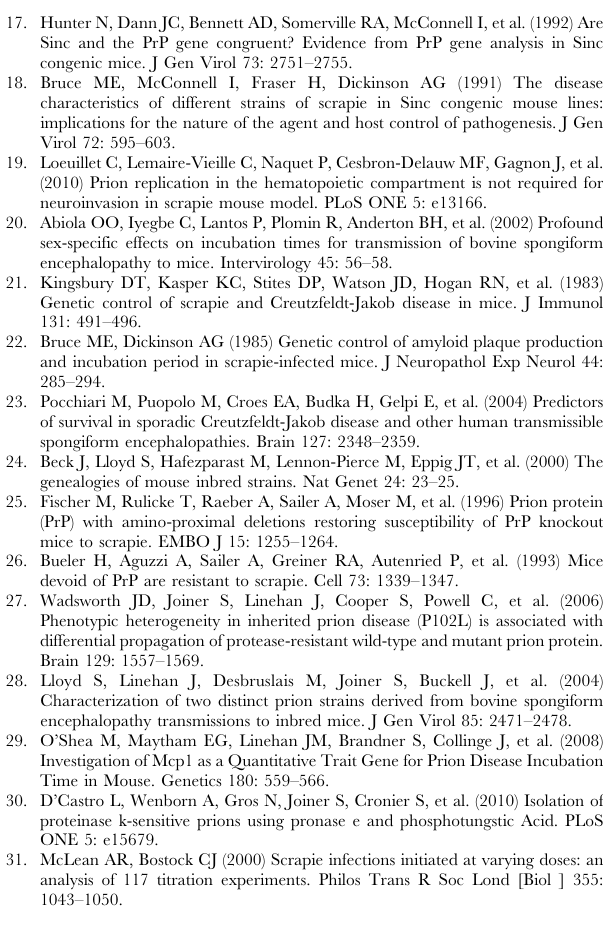
Figure S3 Western blot of PrP Sc from the brains of C57BL/6 and FVB/N mice following MRC2 transmis- sion. Western blot of proteinase-K treated 10% w/v brain homogenates (n= 3 for both males and females) immunoblotted with anti-PrP monoclonal antibody ICSM-35 (D-Gen Ltd, UK). (A) C57BL/6 mice (B) FVB mice. The PrP Sc from both male and female brains is characteristic of the MRC2 prion strain and no sex differences are seen.